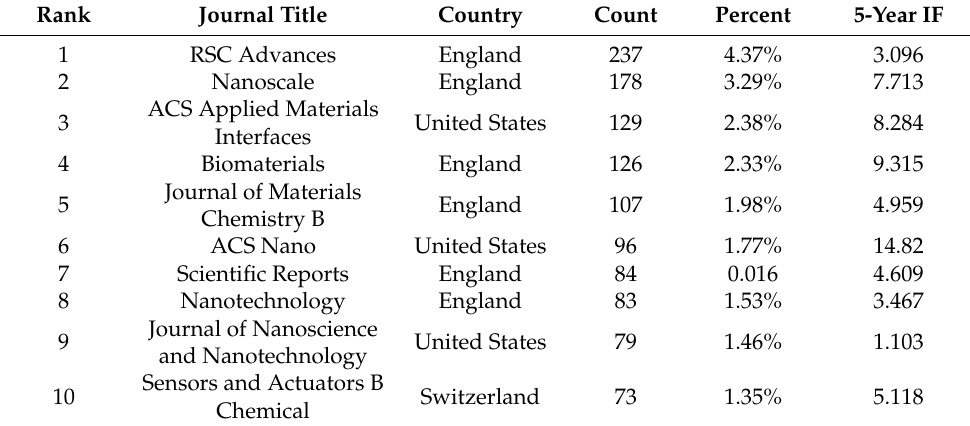
Table 1. The top 10 journals that published articles on QDs toxicity